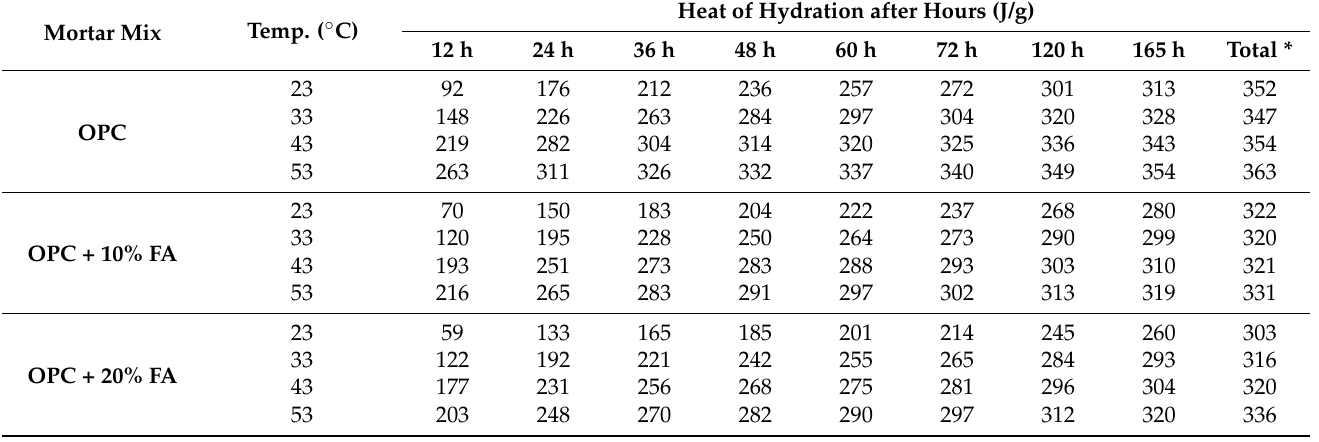
Table 3. Heat of hydration.